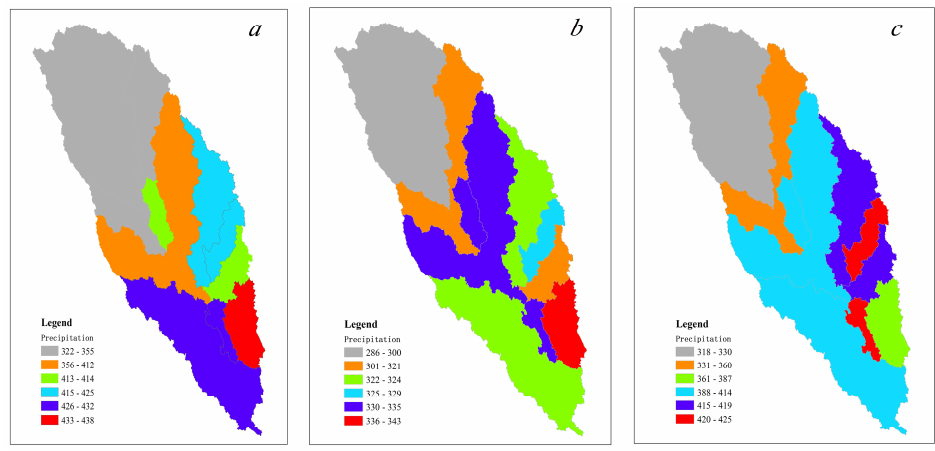
Figure 11. The spatial distribution of areal precipitation obtained by ( a ) OBS; ( b ) CMADS; and ( c ) OBS+CMADS .